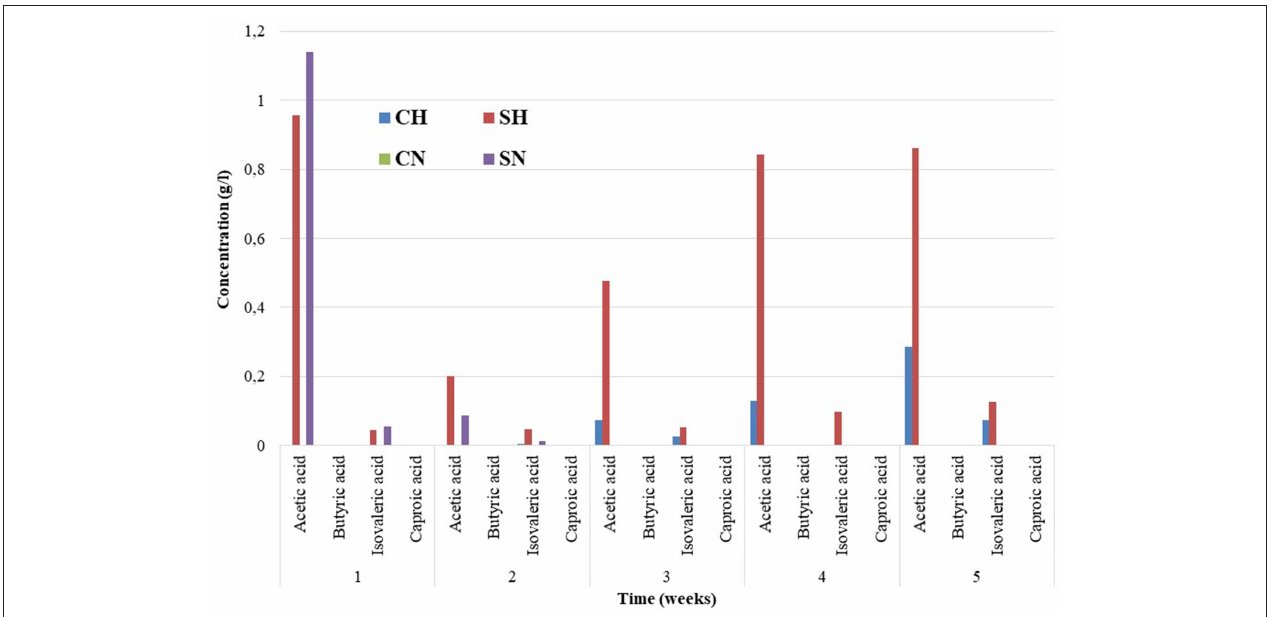
FIGURE 2 | Organic acid levels determined weekly in the reactors. The compositions of the reactors were as in Figure 1 . The triplicate samples were pooled for the HPLC measurements. The long-term experiments were repetitions of the ones published in Szuhaj et al. (2016), that is why they are not reproduced